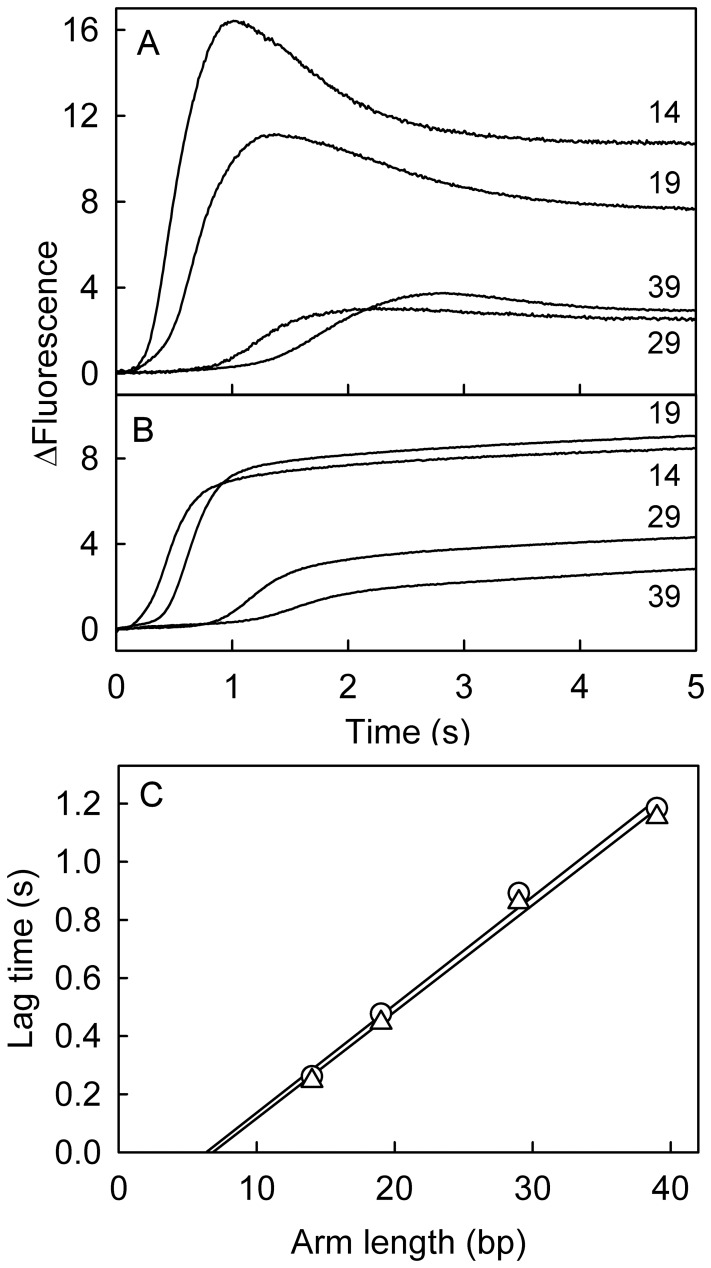
Unwinding 4-strand complementary junctions.(A) Fluorescence changes during unwinding under single turnover conditions junctions (A:B′:C:D) of varying arm lengths (shown in b.p.), labeled with Cy3 and Dabcyl on the template strand duplex. Final concentrations are 30 nM DNA junction, 60 nM RecG and 200 µM ATP. The reaction was initiated by rapid mixing with ATP. (B) Fluorescence changes during unwinding under single turnover conditions of 4-strand complementary junctions (A∶B′∶C∶D), of varying arm lengths (shown in b.p.), labeled with Cy3 and Dabcyl on the leading strand duplex. Final concentrations DNA junction 30 nM, RecG 60 nM and ATP 200 µM. The reaction was initiated by rapid mixing with ATP. Fluorescence levels are expressed relative to the starting value. (C) Change in lag durations with arm length of complementary junctions.: 4-strand with lagging strand labeled (triangles), 3-strand with lagging strand labeled (circles) and 4-strand with leading strand labeled (squares). The length of lags were obtained by the intercept of best fits to the lag phase and the tangent to the rise phase, Lines are linear fits to the data points, and the reciprocal gives rates of unwinding 26.9 (±1.6) bp s−1 for the lagging strand and 26.9 (±1.6) bp s−1 for the leading strand.